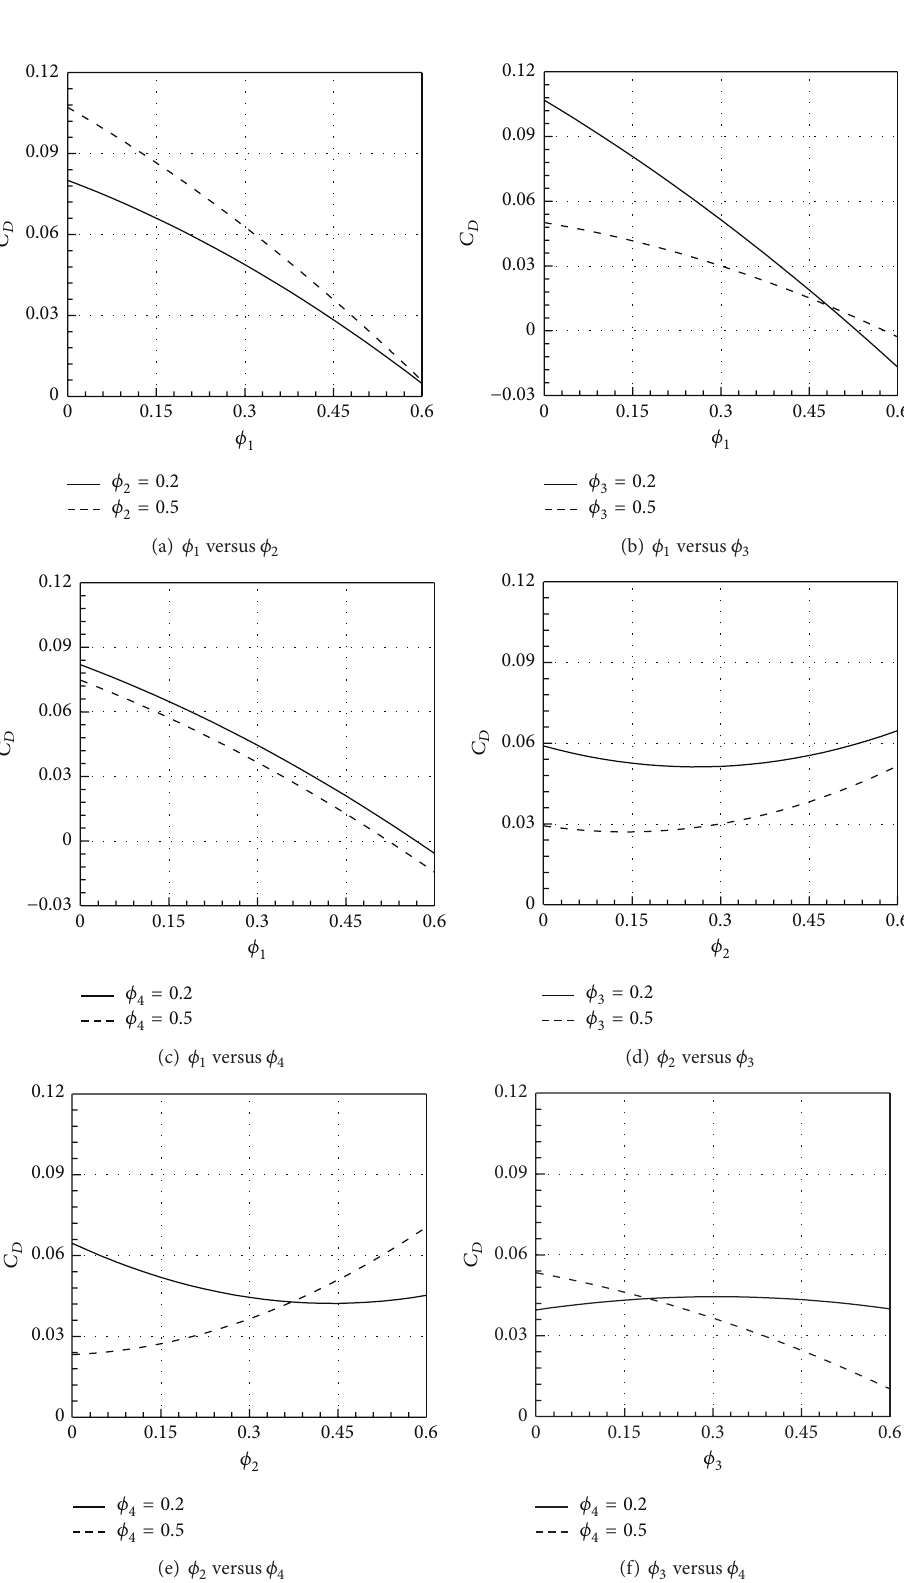
Figure 10: Interaction effects of the design variables on the drag